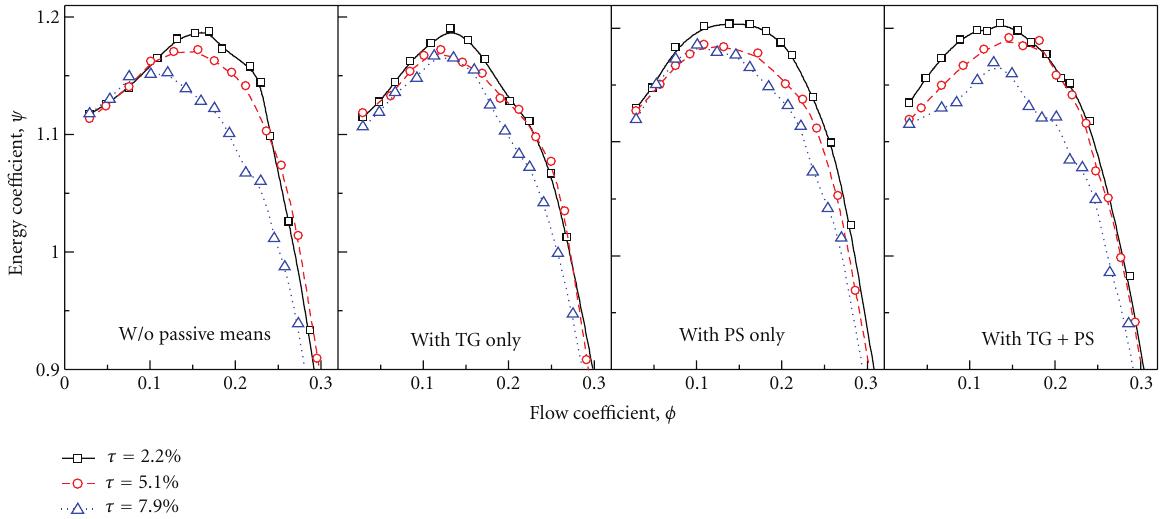
Figure 5: Performance characteristics of the centrifugal compressor ( ψ versus φ ): e ff ect of tip clearance.